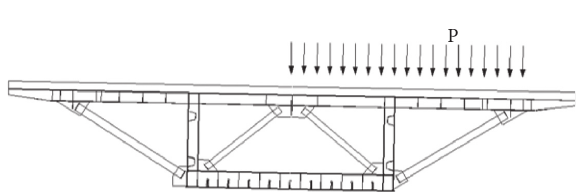
Figure 12: Transverse load